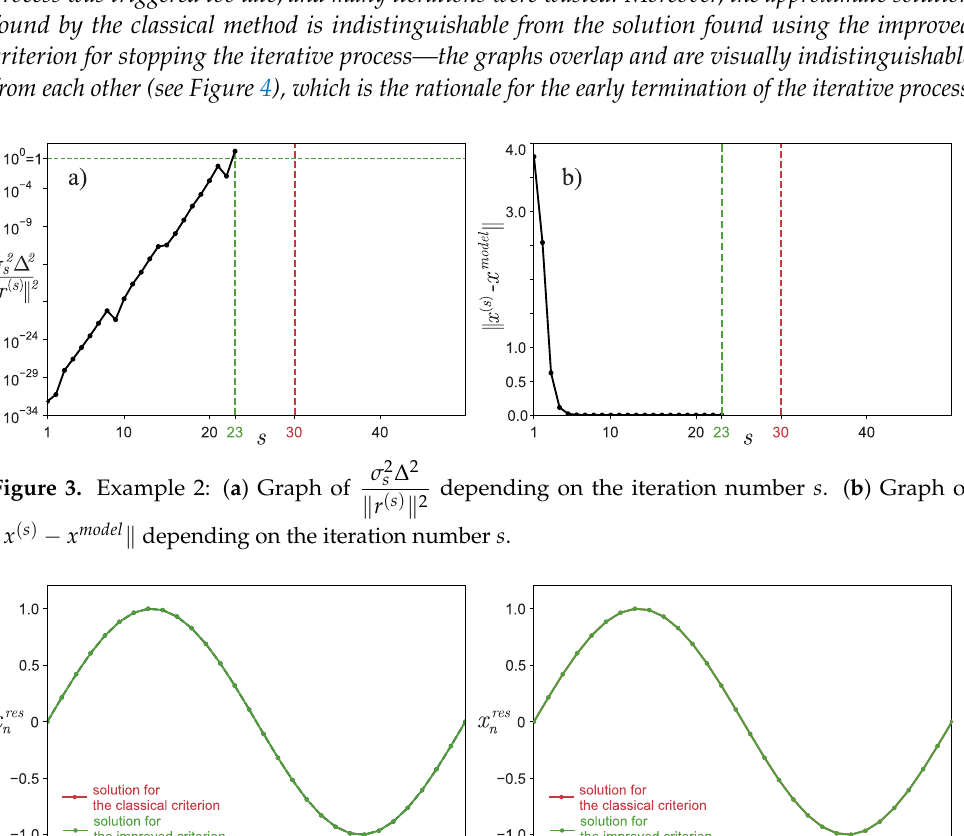
Figure 4. Example 2: Graph of x res n depending on the component index n . Figures correspond to two different arbitrary matrices A . Solutions for different criteria for stopping iterative processes are visually indistinguishable from each other (graphs